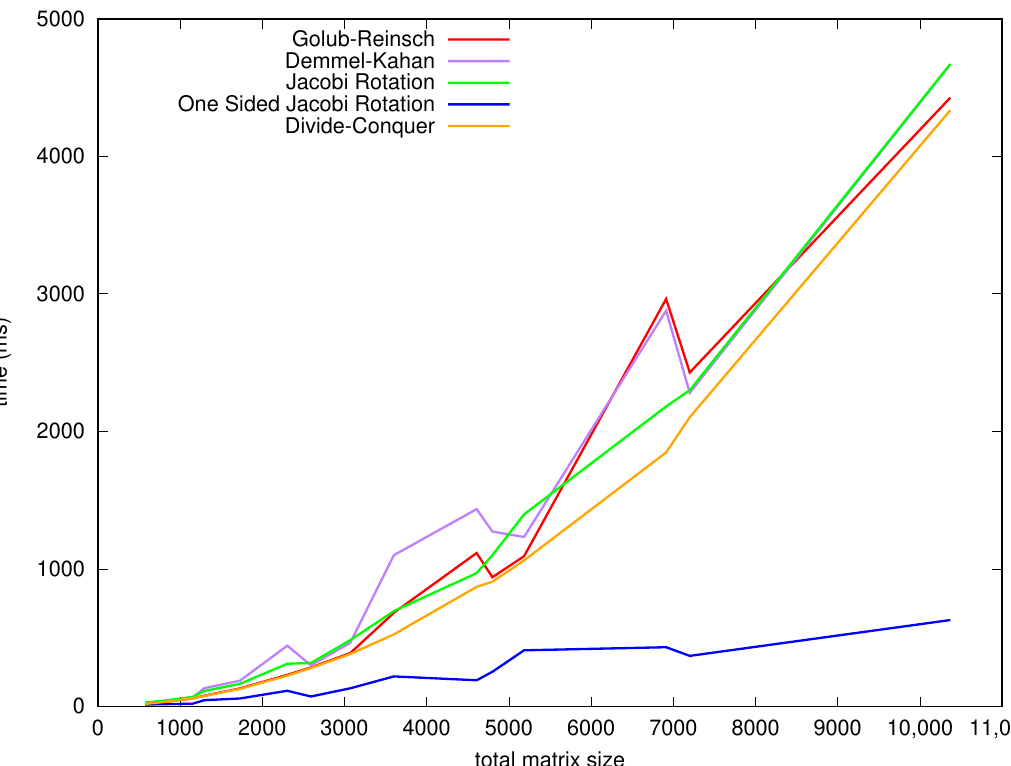
Figure 6. Timings of SVD algorithms on Cortex-M4F with respect to total matrix size m × n